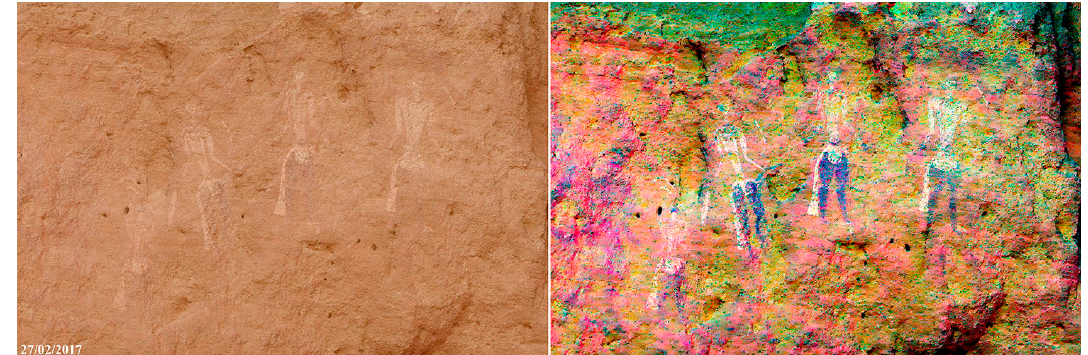
Figure 10. Four figures wearing white clothes, at 4.5 m above the shelter floor at P5 (Photo: Alessandro Menardi Noguera). Legs are painted in dark red (enhanced version to the right in DStretch LAB colour space).